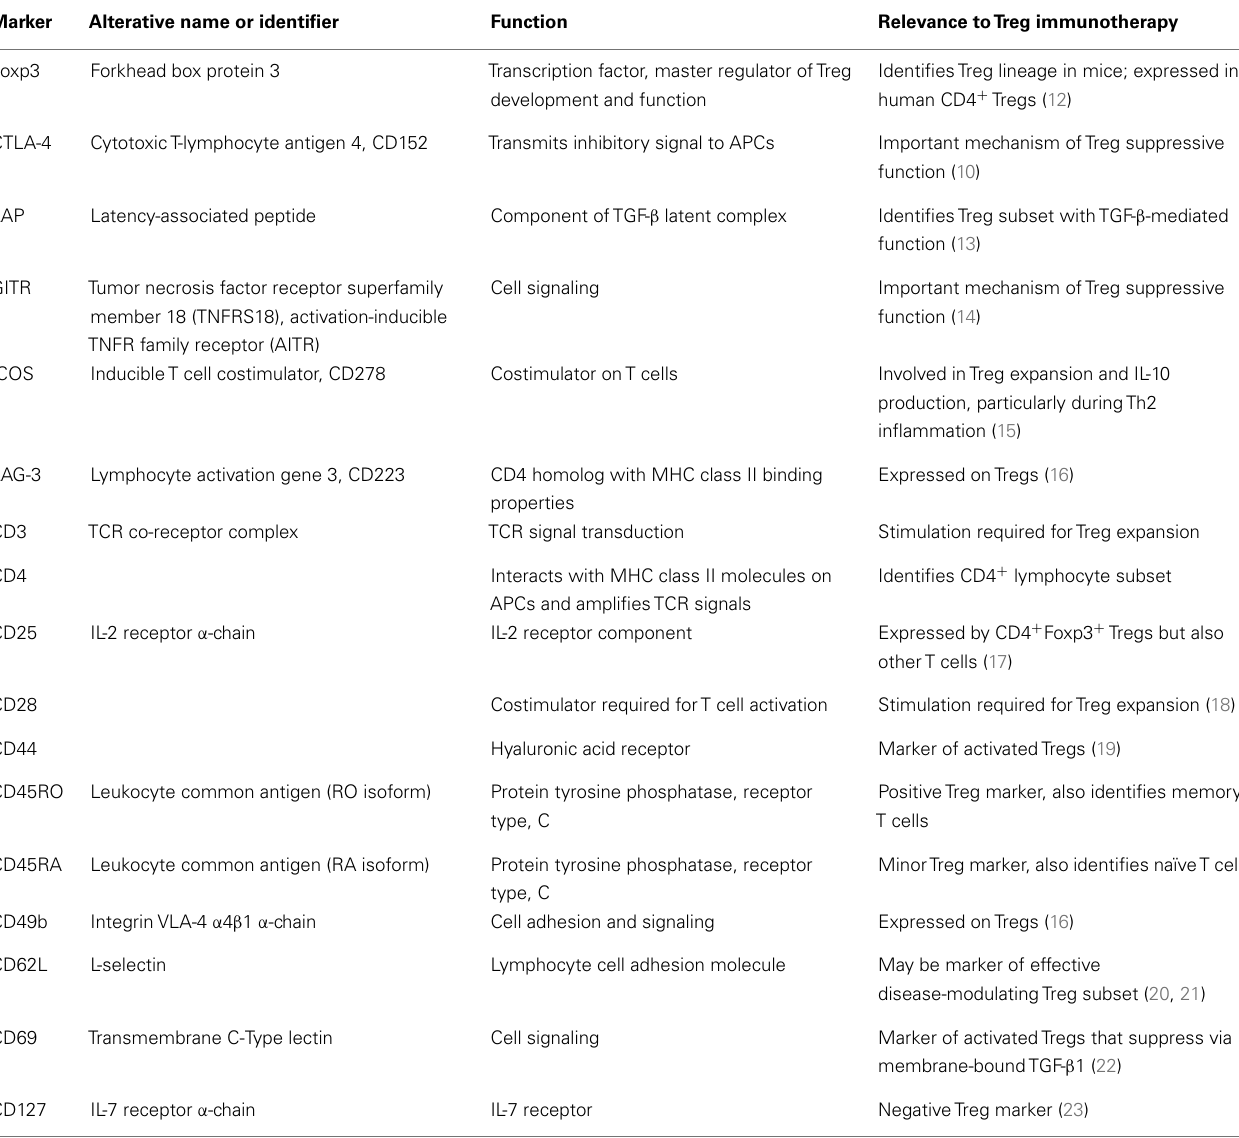
Table 1 |Treg markers relevant to their use as immunotherapy with selected references